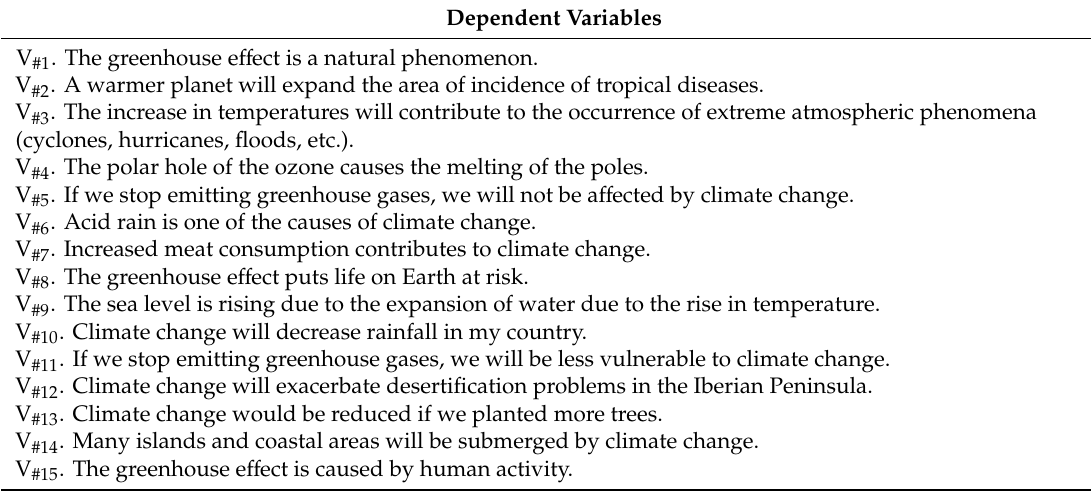
Table 7. Questionnaire questions considered Dependent